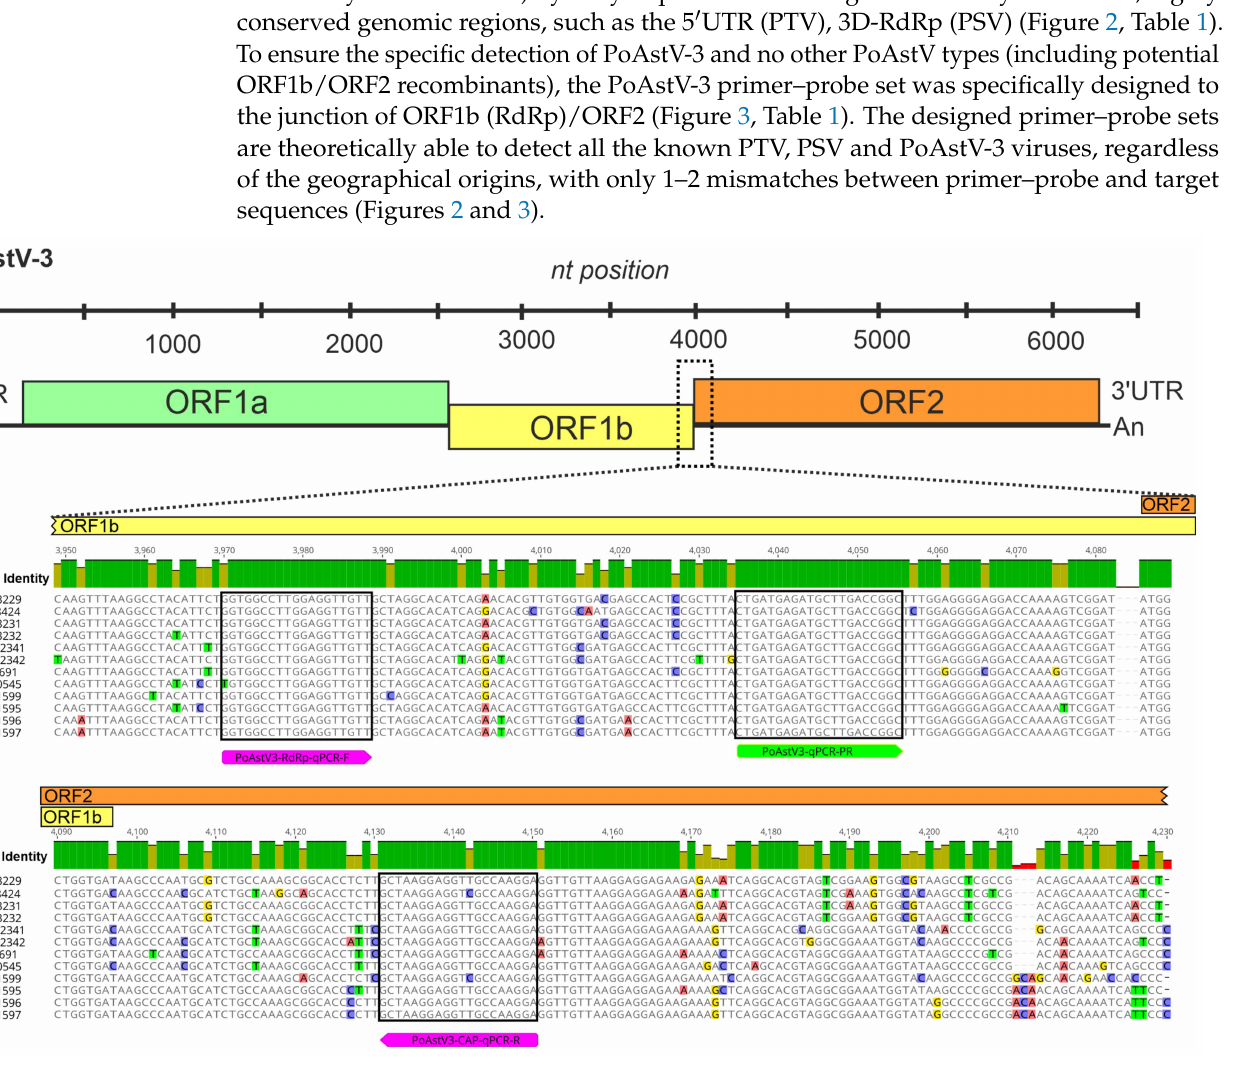
Figure 3. Nucleotide sequence alignment of the partial ORF1b-ORF2 junction of all publicly available porcine astrovirus type 3 (PoAstV-3) viruses with the binding sites of oligonucleotide primers (magenta) and a probe (green) used in singleplex/triplex RT-qPCR assay of this study. The location of the aligned region and primer–probe binding sites are marked with dotted lines in the schematic astrovirus genome map. The identity graph above the alignment shows the identical (green bars) highly (red bars) and moderately variable (pale yellow bars) genomic